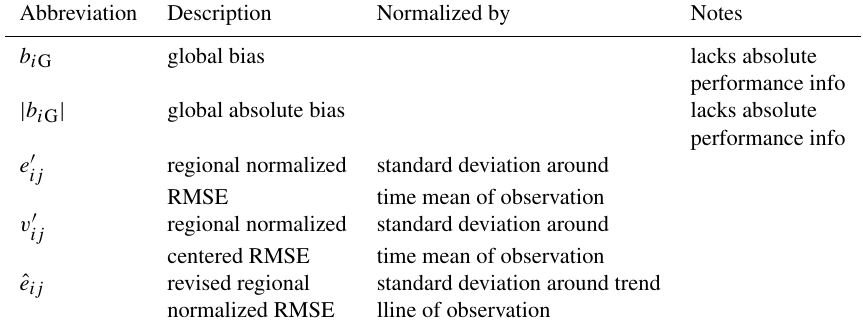
Table 1. Statistics for model